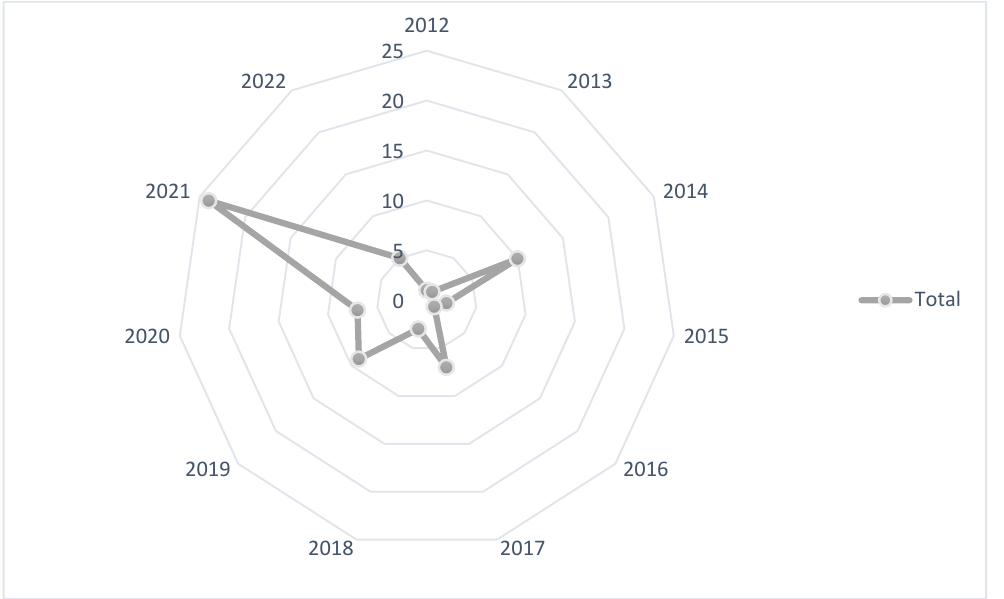
Table 2. Inclusion–exclusion criteria of relevancy.